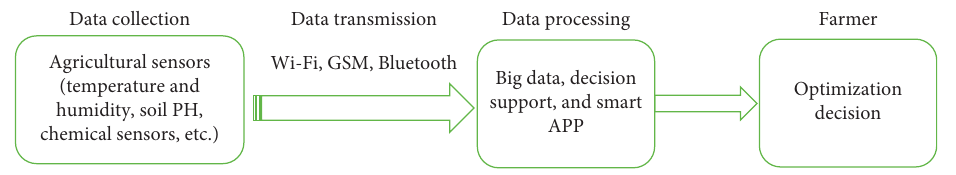
Figure 1: The Internet of Things